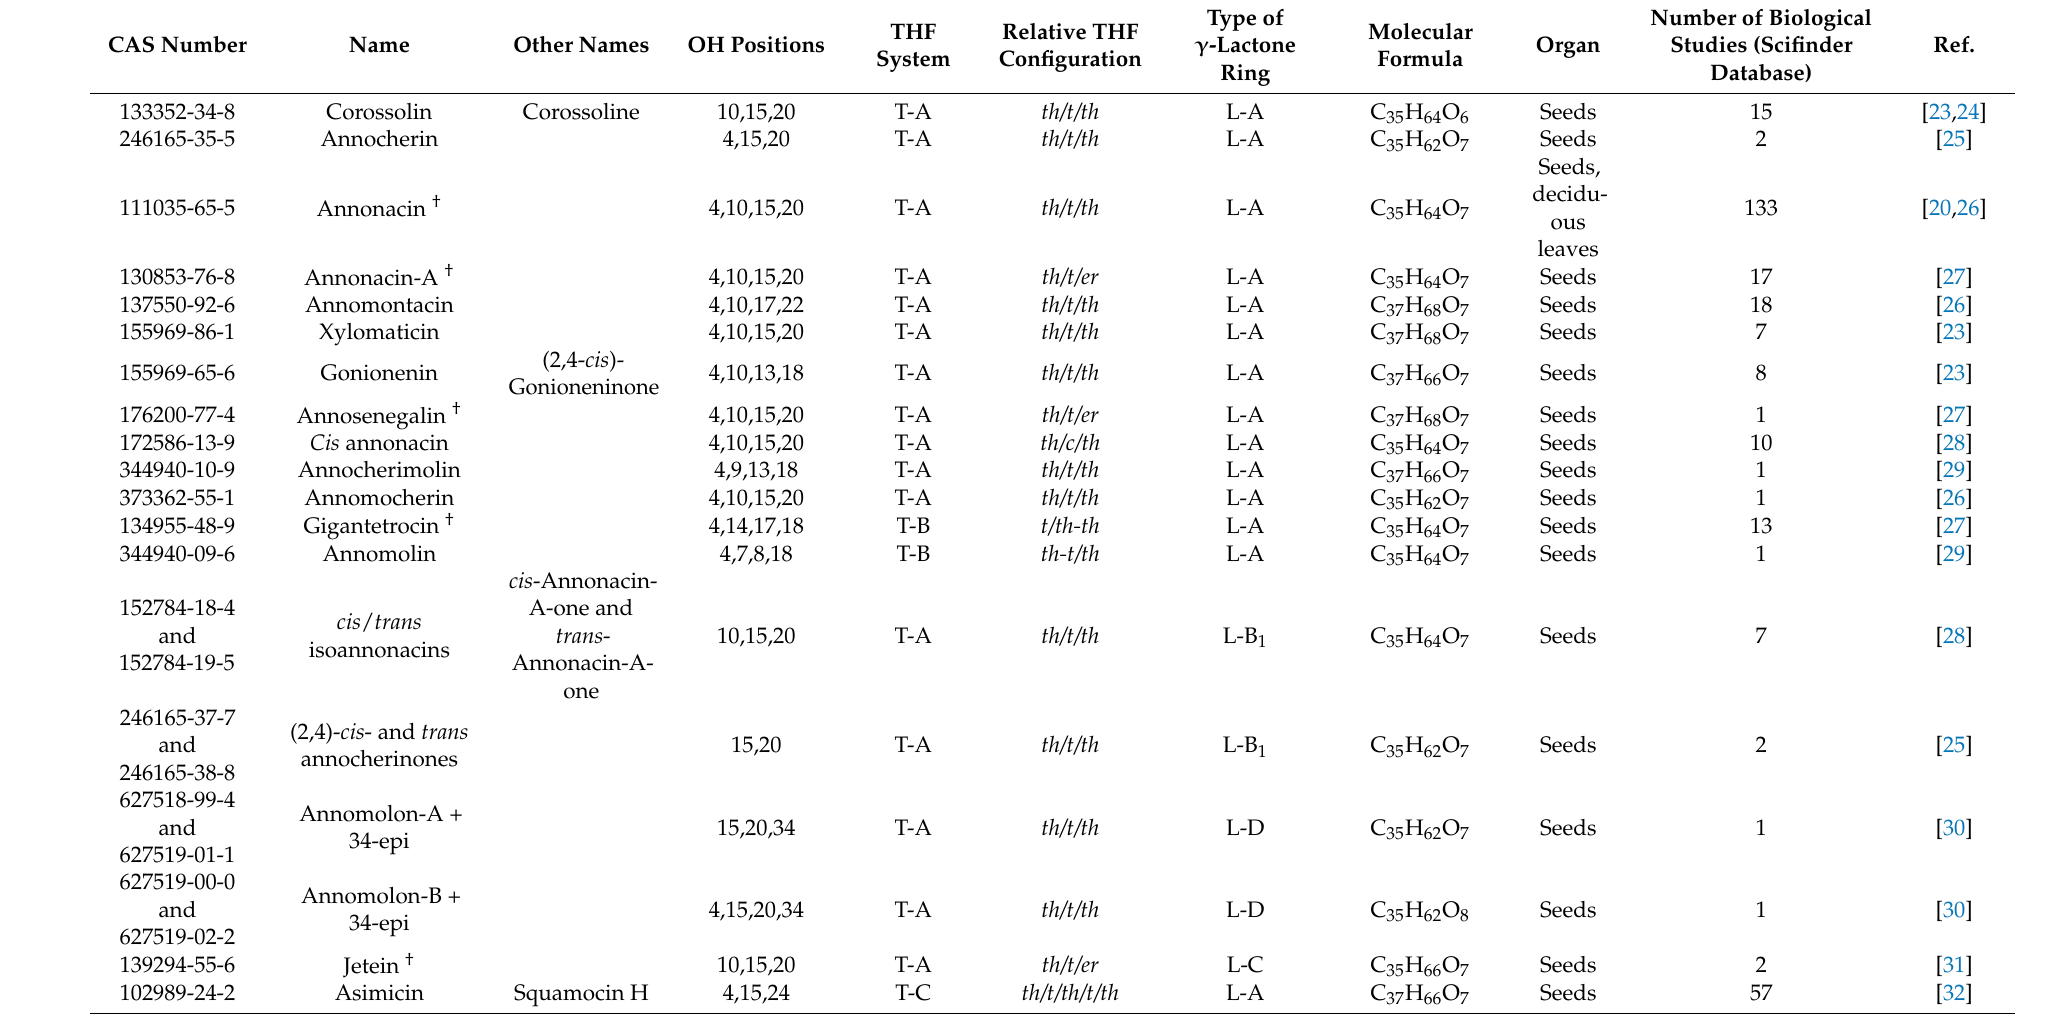
Table 1. Characteristics and structural features of the 41 ACGs described in